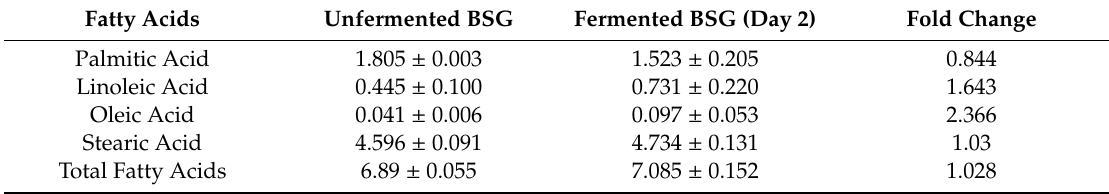
Table 2. Fatty acids results (mg / g) in BSG before and after fermentation.